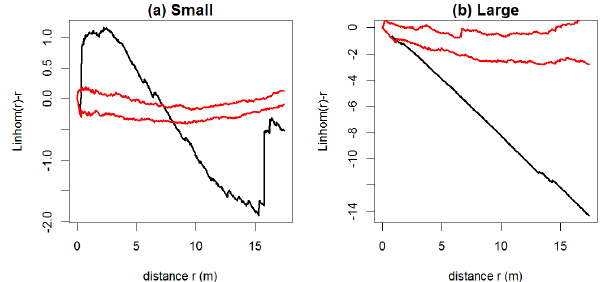
Figure 8. Empirical inhomogeneous L function (minus the dis- tance r ) calculated for winter 2006 data set with Ripley’s edge correction (black-coloured lines): for the small erosion scars, (a) (10 − 3 ≤ volume ≤ 10 − 2 m 3 ) and for the large scars (b) (10 − 2 ≤ volume ≤ 10 1 m 3 ). The limits of the significance envelope (calculated through a Monte-Carlo procedure) at level of 2% are depicted by red